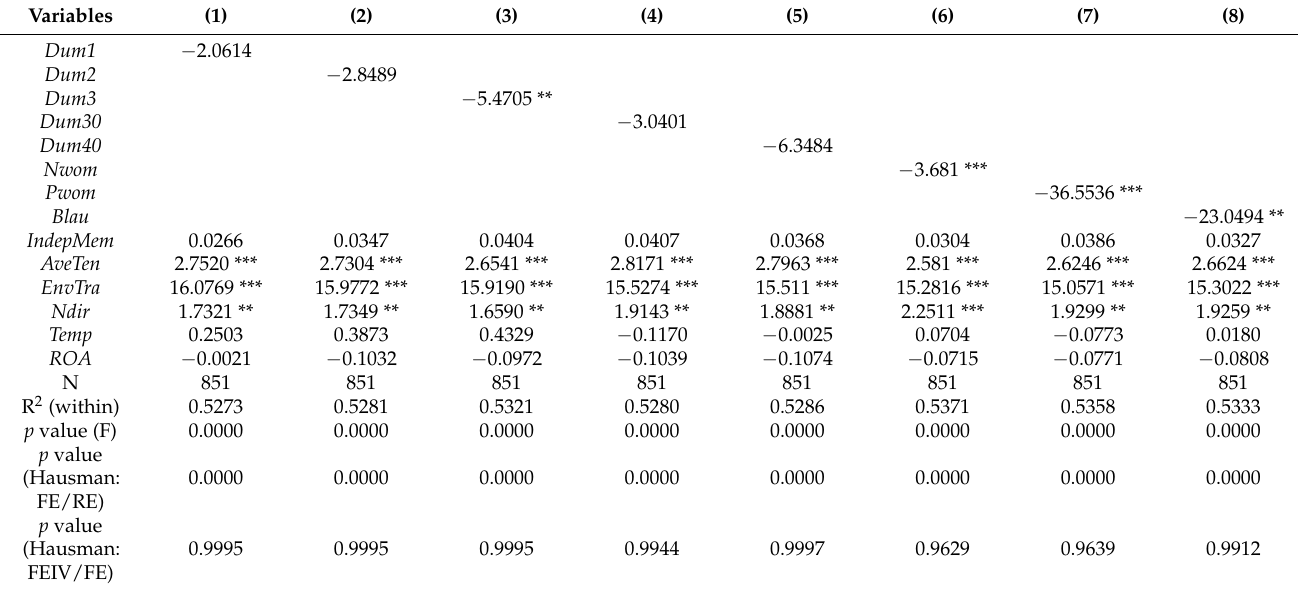
Table 9. Dependent variable: EmiSc . Fixed effects estimator (2002–2019).